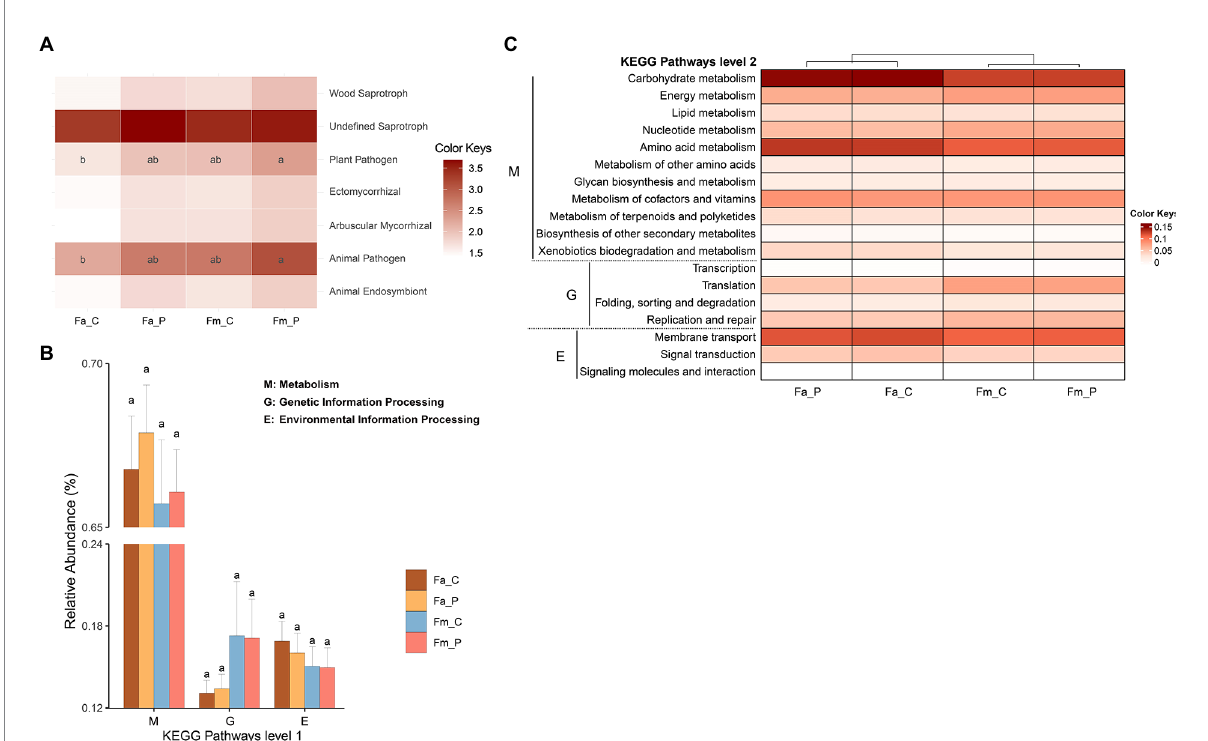
FIGURE 4 The function prediction of microbial communities. (A) Heatmap plot of fungal functional guilds produced by FUNGuild analysis. (B) Bar plots of the prediction Kyoto Encyclopedia of Genes and Genomes (KEGG) pathway level 1 obtained from Tax4Fun2 for each sample of bacterial community. (C) Heatmap of the functional abundances at the KEGG metabolic pathway level 2 obtained from Tax4Fun2 for each sample of bacterial community. The color bar reflects the value of functional abundance. The letters in each panel were calculated by the least significant difference (LSD) test, the same letter represents no differ significantly. The relative abundance of pathways with 0.05 cutoff (not shown). Fa_C represents the cheater of F. altissima ; Fa_P represents the pollinator of F. altissima ; Fm_C represents the cheater of F. microcarpa ; Fm_P represents the pollinator of F. microcarpa